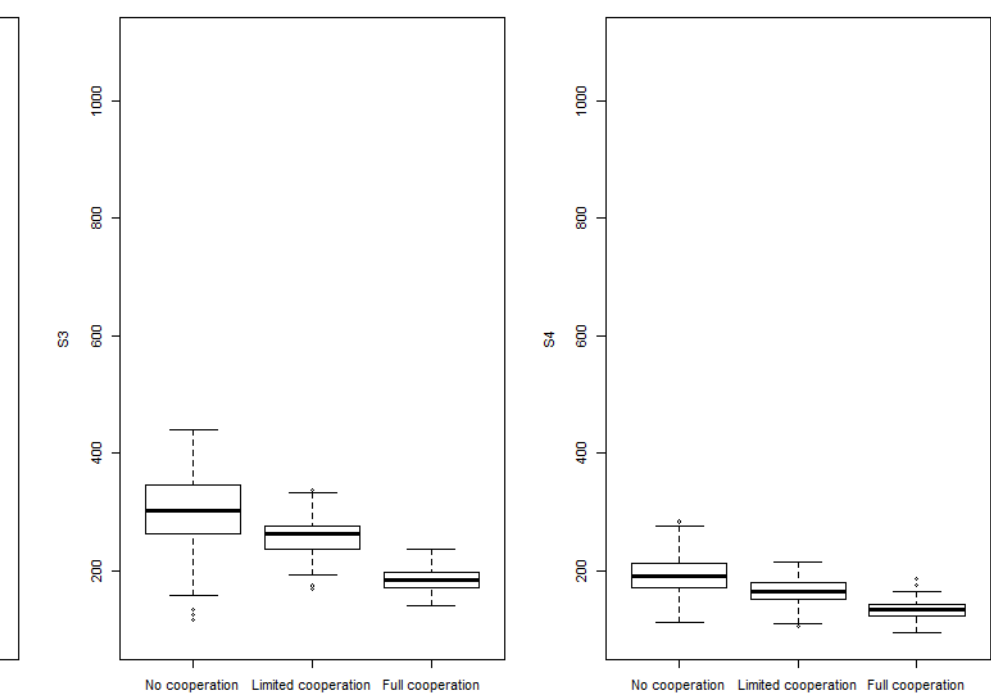
Figure 9. Boxplots for the average distance driven in the 100 replications for non-, limited, and full cooperation settings for each